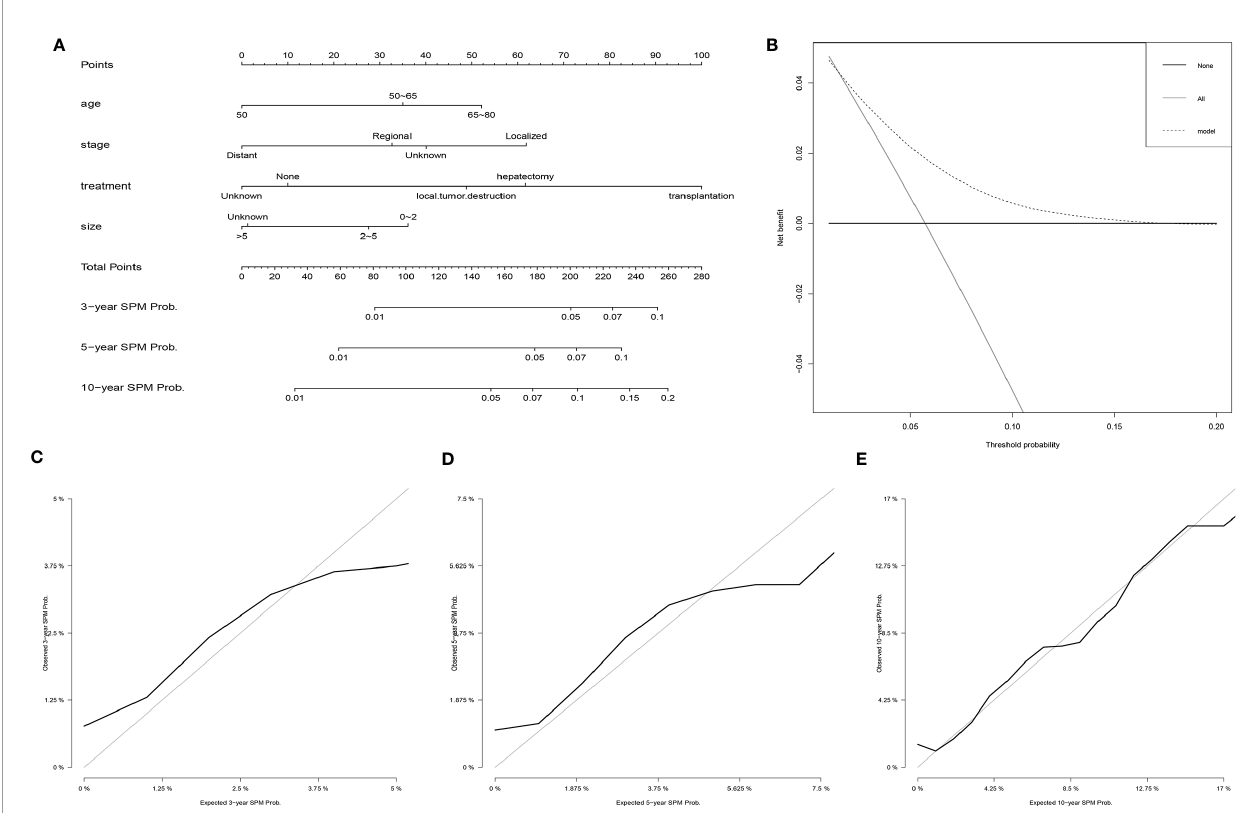
FIGURE 3 | Establishment and validation of a competing-risk nomogram to predict the 3-, 5-, and 10-year probability of developing SPMs for HCC patients after initial diagnosis. (A) The competing-risk nomogram for predicting the 3-, 5-, and 10-year probability of developing SPMs for HCC patients after initial diagnosis. (B) DCA for assessing the clinical net bene fi t of the nomogram. Calibration curves of the competing-risk nomogram for predicting the 3- (C) , 5- (D) , and 10-year (E) probability of developing SPMs for HCC patients after initial diagnosis. HCC, hepatocellular carcinoma; SPM, second primary malignancy; DCA, decision curve analysis.